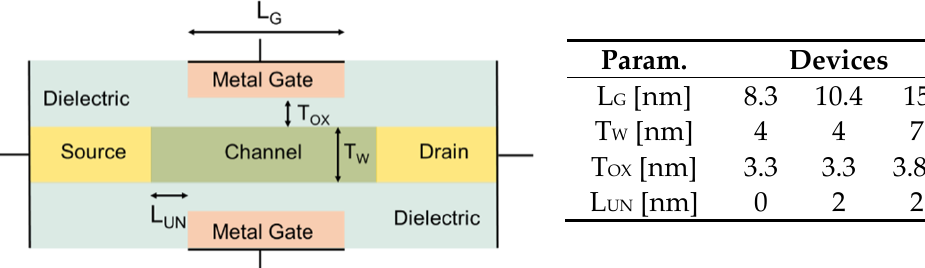
Figure 4. Sketch of the simulated devices and table with geometrical parameters. The NEGF solver is described in [45]. It includes only the Γ valley of the conduction band, differently from the MV–MSMC that models also satellite valleys. We however verified that the occupation of satellite valleys is negligible in the simulations reported here. Since scattering is not included in the NEGF simulator, scattering was turned off in the MV–MSMC as well, for a fair